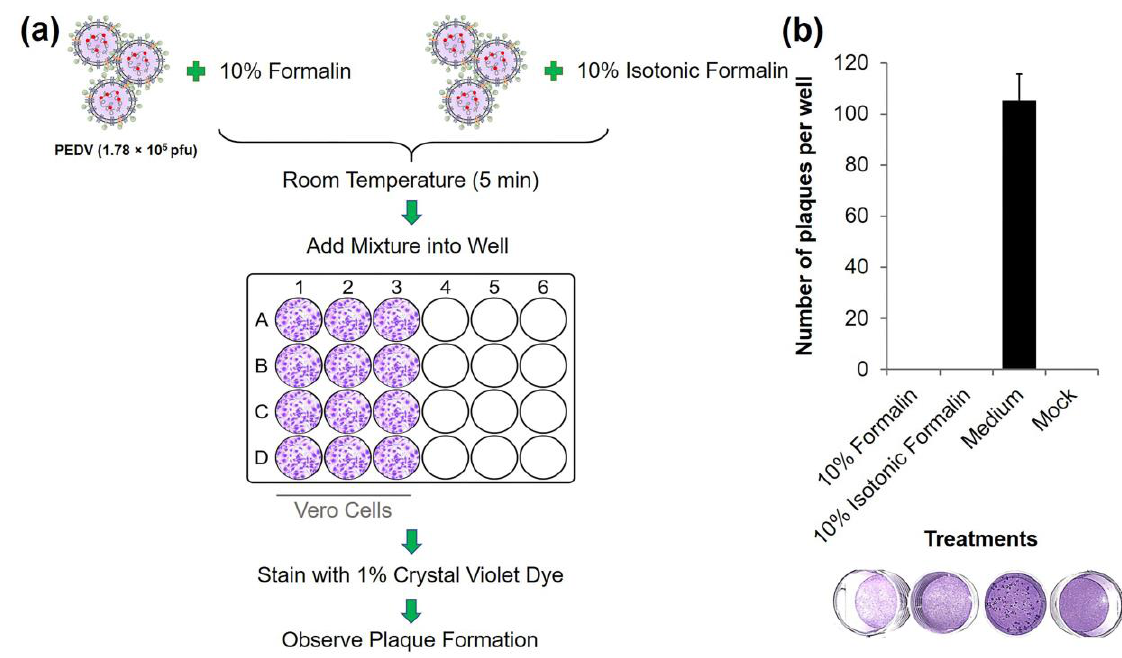
Figure 1. Inactivation activities of 10% formalin and 10% isotonic formalin on porcine epidemic diarrhea virus (PEDV): ( a ) Flow diagram of in vitro inactivation assay. ( b ) Number of plaques per well of 10% formalin- and 10% isotonic formalin-treated PEDV at 5 min of treatment at room temperature. Virus in medium alone and noninfected Vero cells (mock) were used as a negative inactivation control and a negative plaque formation control, respectively. The results are shown as the mean ± standard deviation (SD) of a representative of three independent experiments.